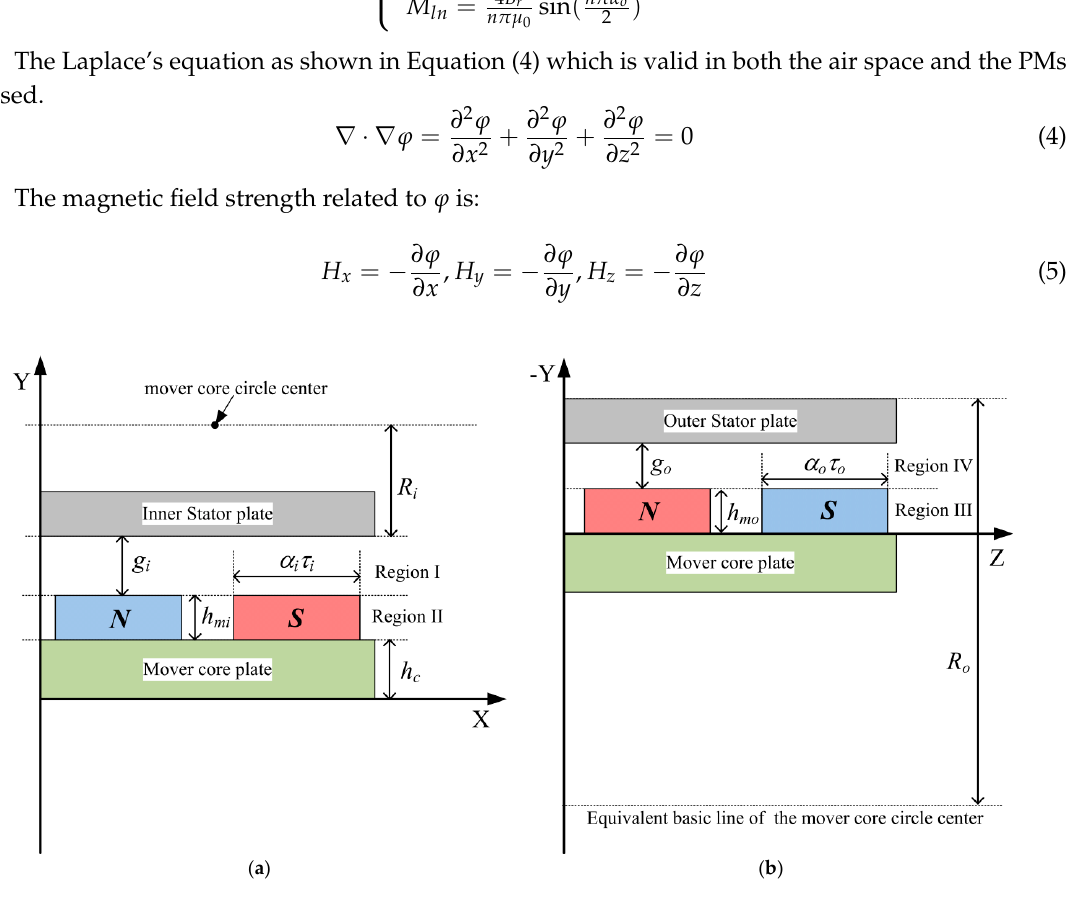
Figure 4. Model of no-load air-gap flux caused by magnets. ( a ) Field region of the rotary motion unit in XY plane; and ( b ) field region of the linear motion unit in ZY plane. By applying the following boundary conditions to Equation (4):